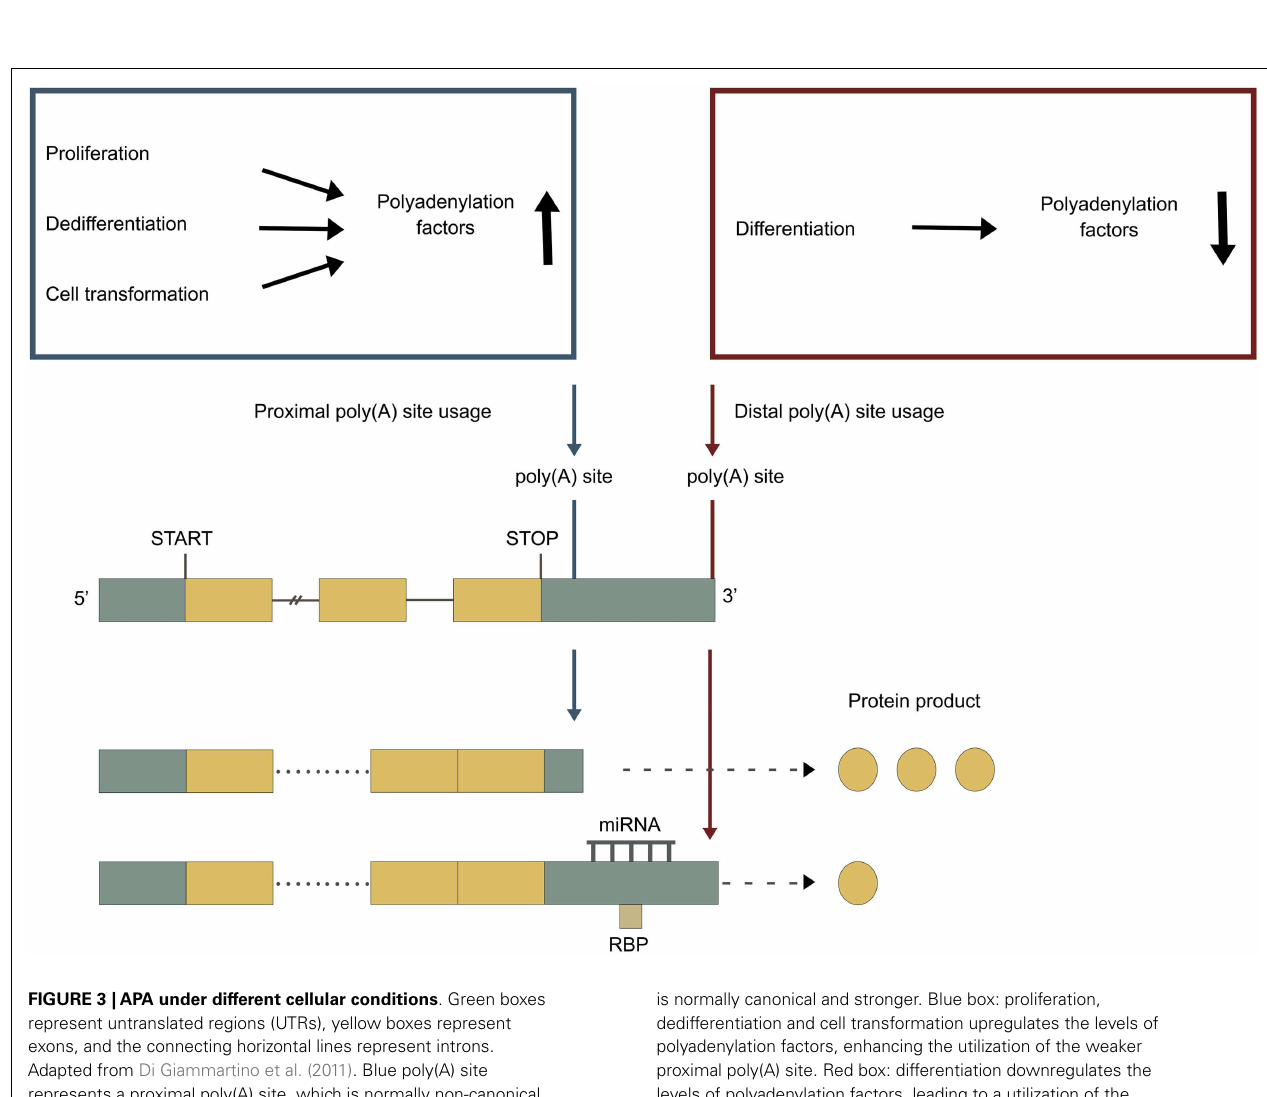
is normally canonical and stronger. Blue box: proliferation, dedifferentiation and cell transformation upregulates the levels of polyadenylation factors, enhancing the utilization of the weaker proximal poly(A) site. Red box: differentiation downregulates the levels of polyadenylation factors, leading to a utilization of the stronger distal poly(A)